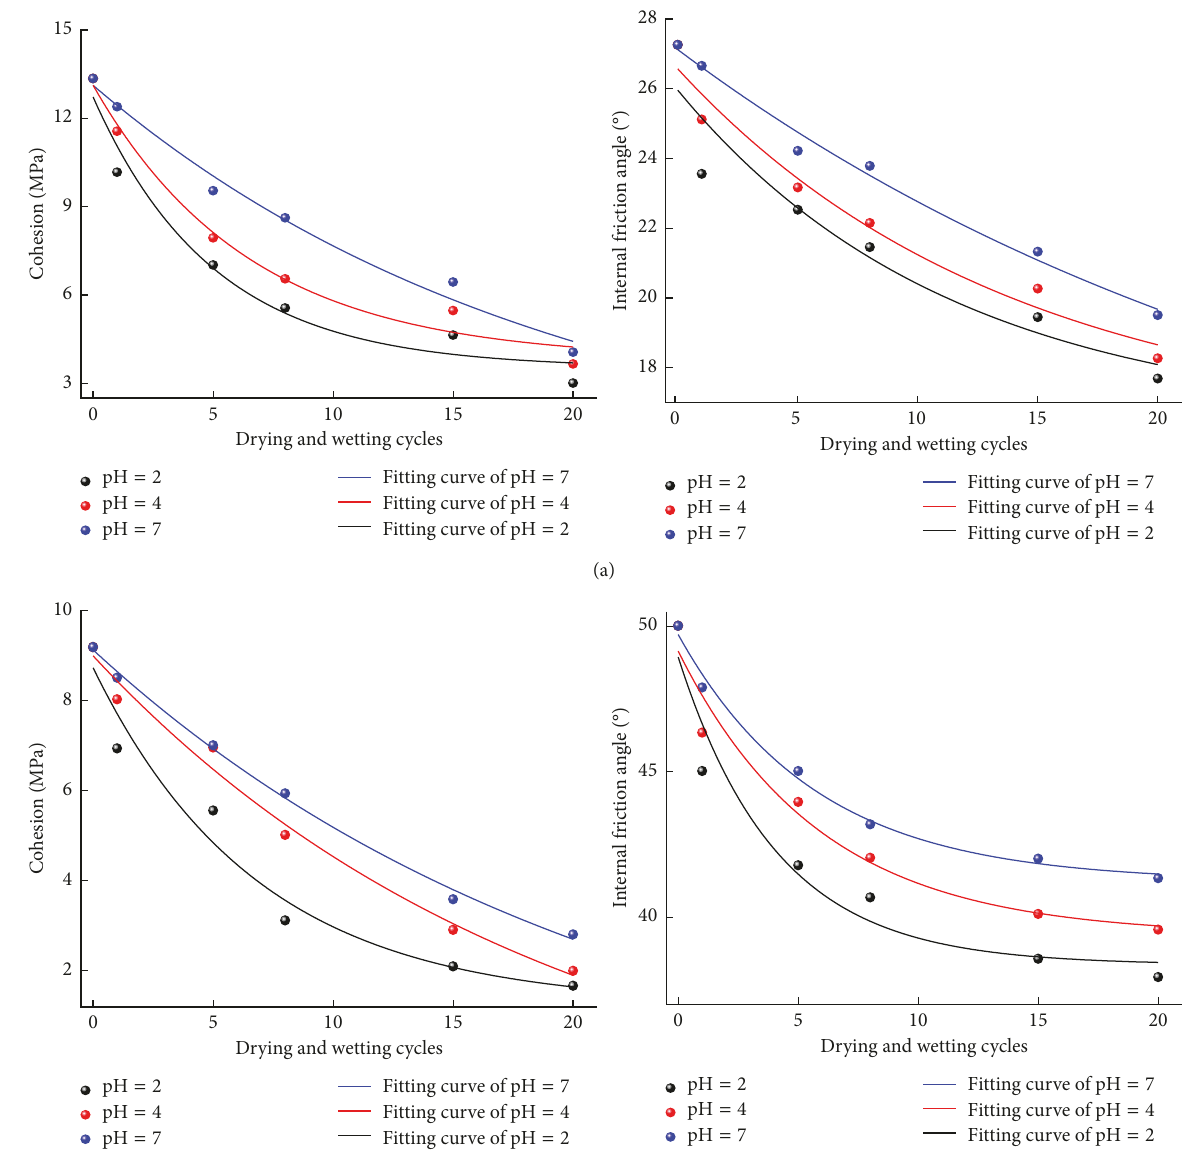
Figure 8: The fitting relationship between shear strength parameters and cycles. (a) Beresitization granoclastic. (b) Beresitization granite.